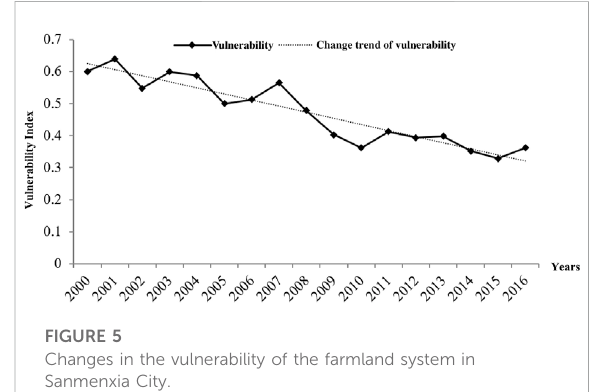
FIGURE 5 Changes in the vulnerability of the farmland system in Sanmenxia